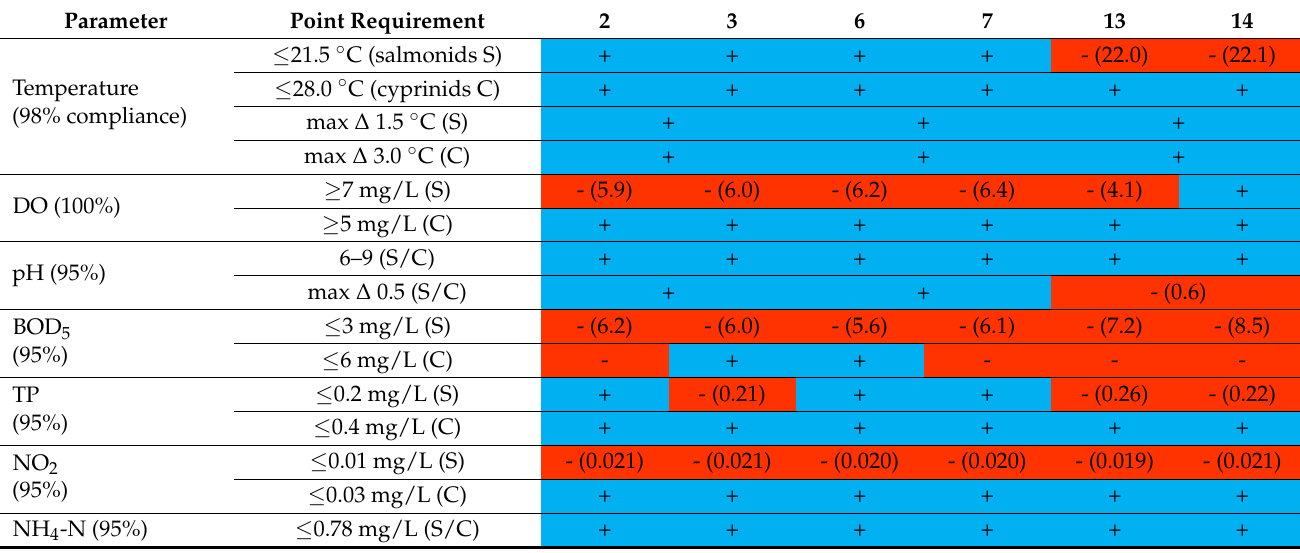
Designations in the table: blue = compliance with requirements, red = noncompliance with requirements, numeric values = physicochemical parameter values for the specified compliance